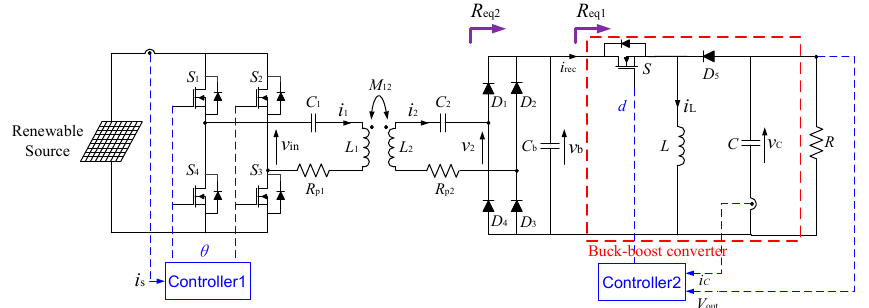
Figure 7. Schematic diagram of a typical two-stage SS-compensated wireless power transfer (WPT) system.